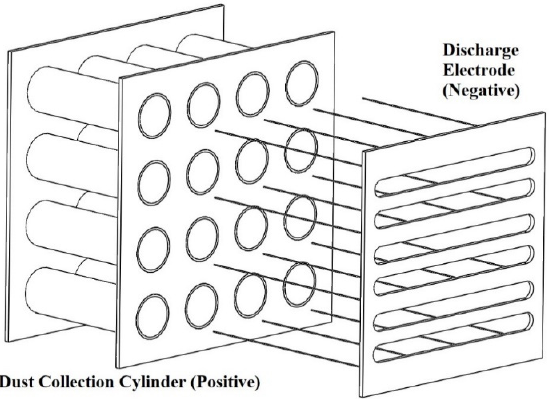
Figure 1. Side schematic view of electrode module in ESP.